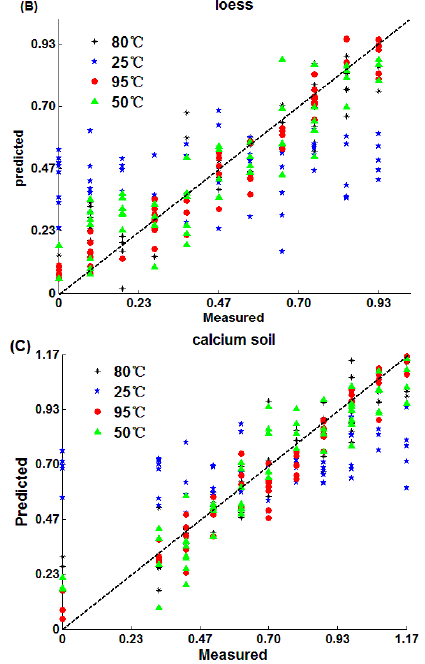
Figure 5. The prediction effect by PLS: ( A ) black soil; ( B ) loess; ( C ) calcium soil.